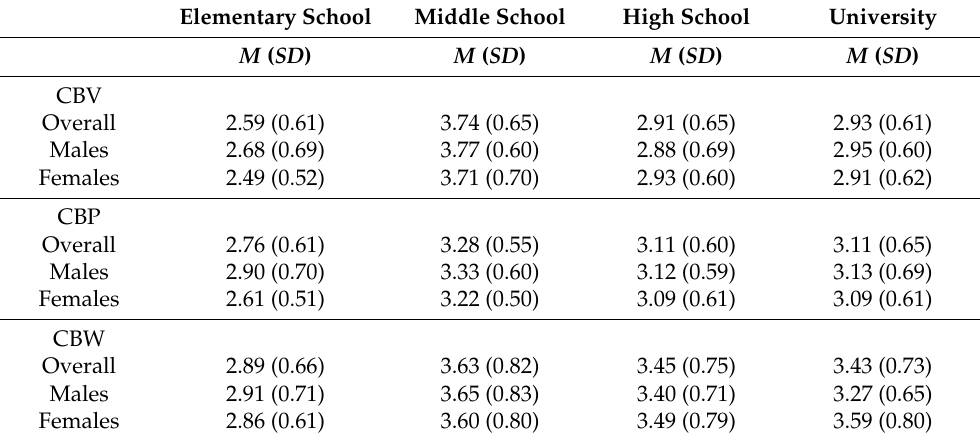
Table 2. Means and standard deviations for cyberbullying involvement by age group.